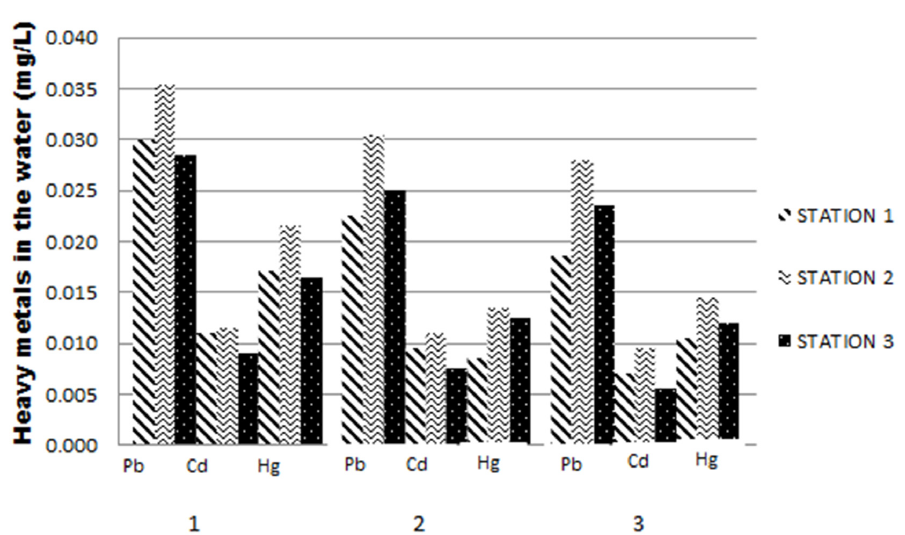
Figure 1. Heavy metal level (Pb, Cd, Hg) at the three stations. Station 1, Mayangan; Station 2, Kenjeran; Station 3, Gresik